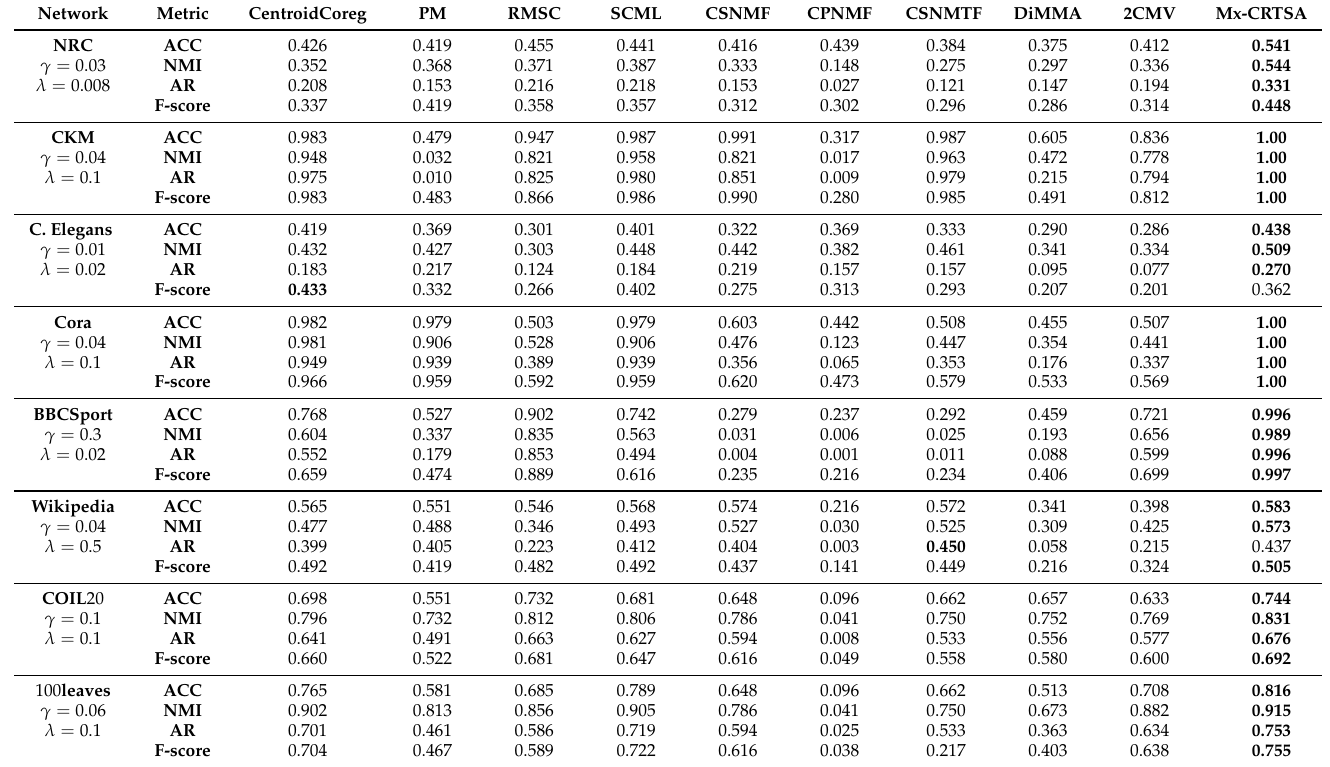
Table 4. Performance comparison between the different algorithms including the proposed Co- regularized Robust Tensor-based Spectral Approach ( Mx-CRTSA ) for the real-world multiplex networks. The best performance is in boldface.